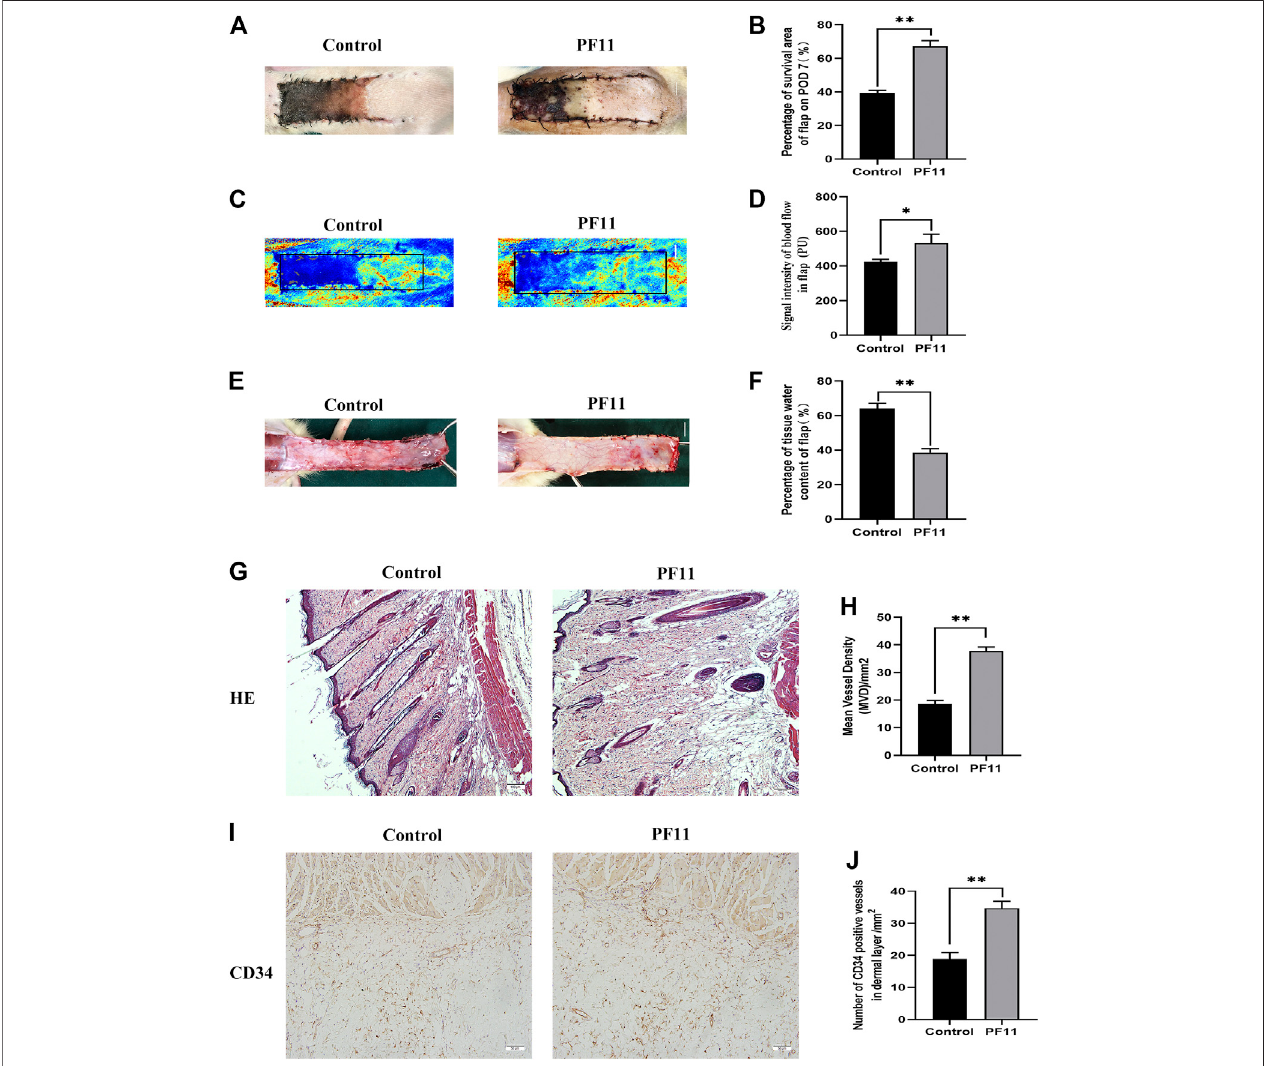
FIGURE1|(A) Digitalphotographs of fl apon the7th POD(scalebar, 1 cm). (B) The histogram showing thepercentage ofsurvival areaofthe fl ap onthe 7thPOD. (C) Laser Doppler images showing vascular network and blood supply on the 7th POD in the control and PF11 groups (scale bar, 1 cm). (D) Histogram showing the signal intensity of blood fl ow. (E) Photograph showing edema on the inner side of the skin fl ap (scale bar, 1 cm). (F) Histogram showing the percentage of tissue water content (G,H) H&EstainingshowingMVDinAreaIIof fl apsinthecontrolandPF11groups(originalmagni fi cation × 100;scanbar,100 μ m). (I,J) IHCresultsshowing the density of CD34 labeled vessels (/mm 2 ). Values are expressed as means ± SD, n (cid:2) 6 per Group. * p < 0.05 and ** p < 0.01, vs. control group.